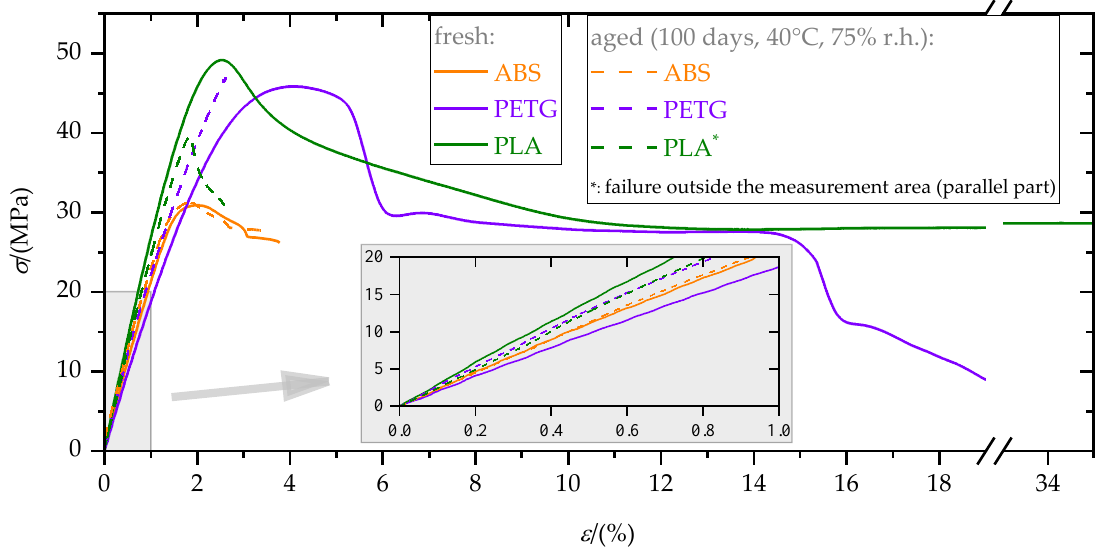
Figure 11. Exemplary stress–strain diagrams, σ ( ε ), of the polymers in the fresh and aged state. Graphs in the enlarged section are shifted to (0/0).